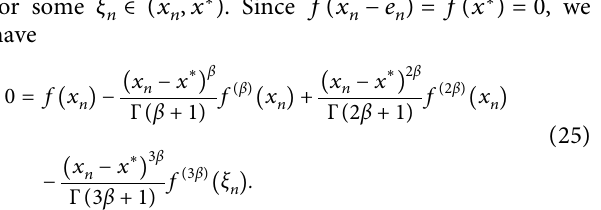
( x ) with Caputo derivative and initial guess x 1